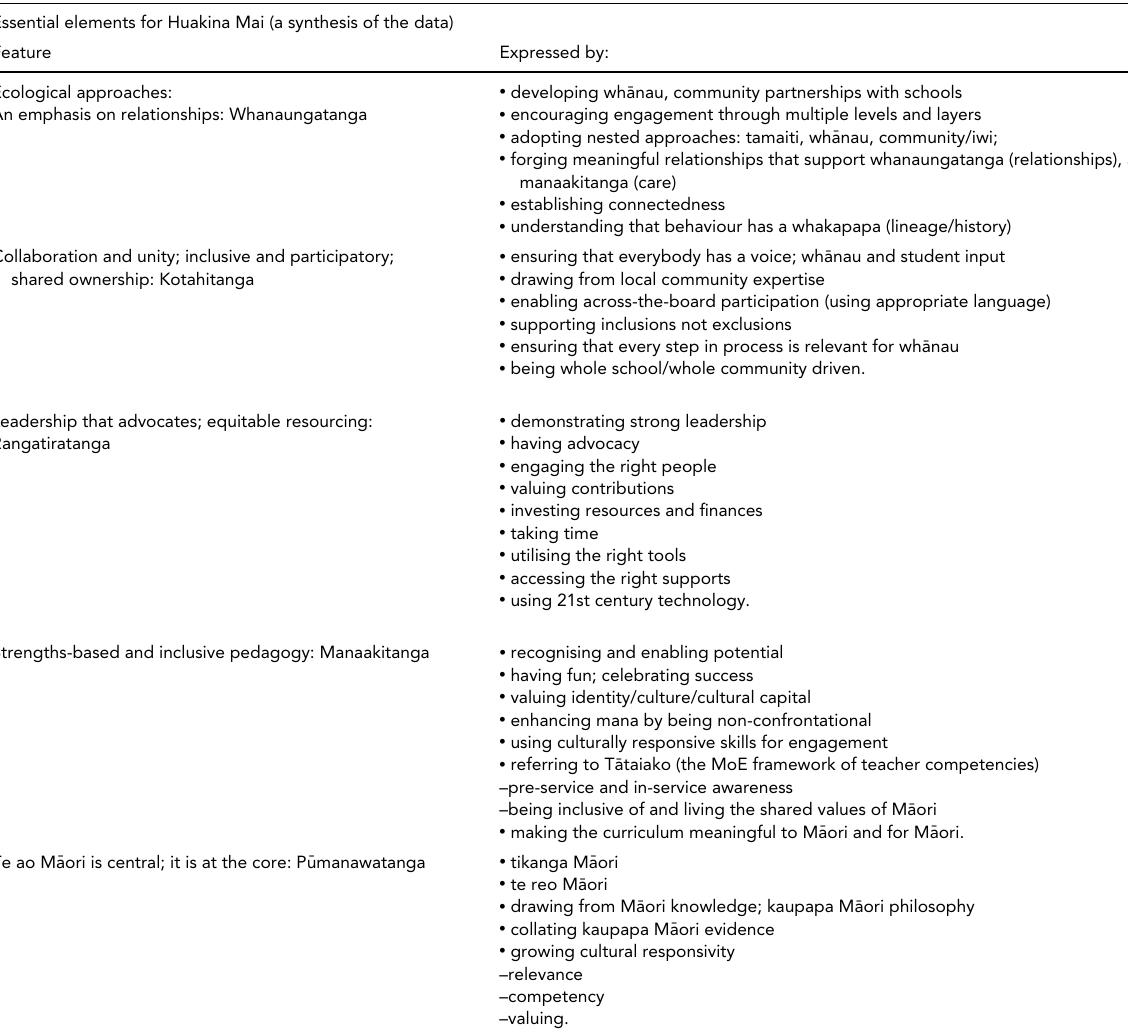
TABLE 1 Emerging Themes and Elements Essential elements for Huakina Mai (a synthesis of the data)